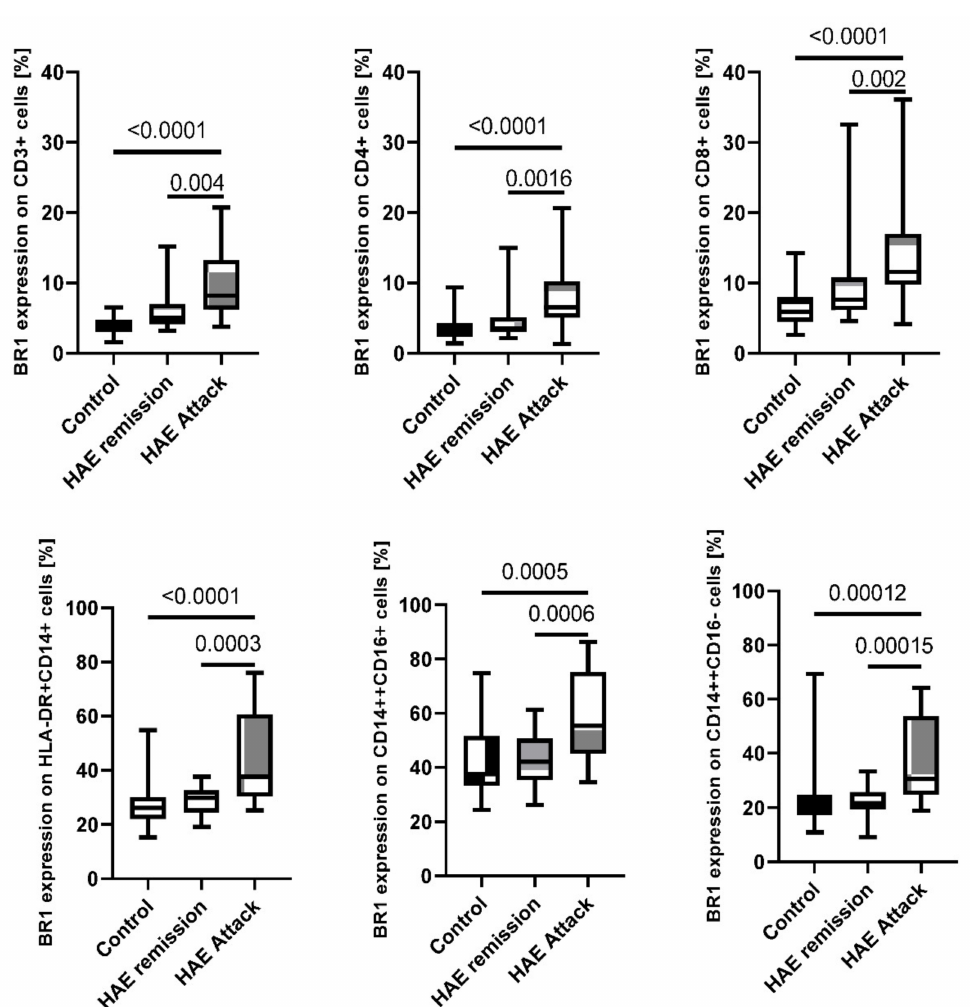
Figure 3. BR1 expression on subpopulations of lymphocytes and monocytes among HAE patients during attack and in the remission compared to the healthy control